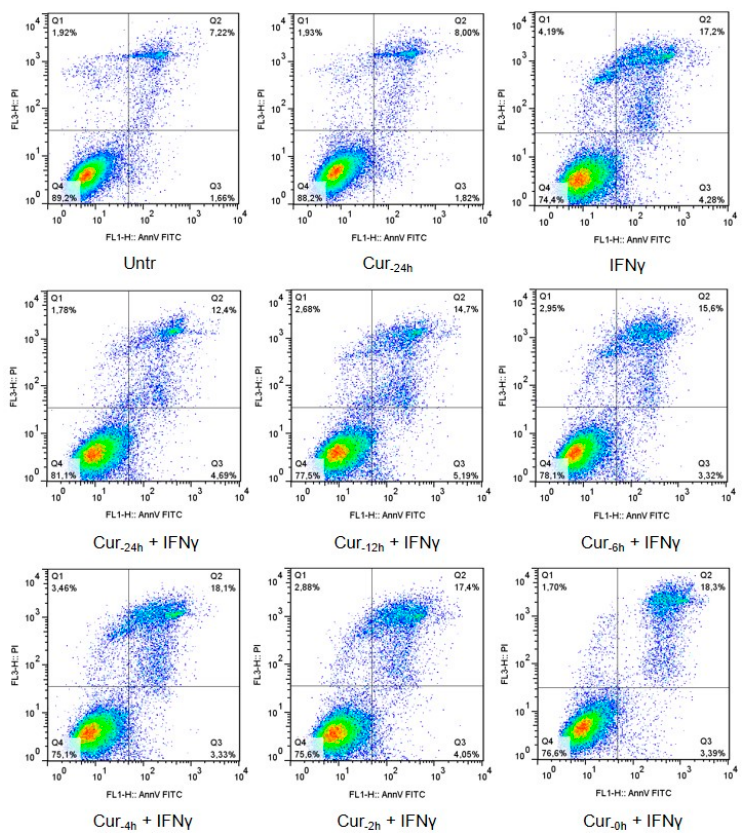
Figure 2. Representative flow cytograms of Annexin V-propidium iodide staining, for each experimental condition.